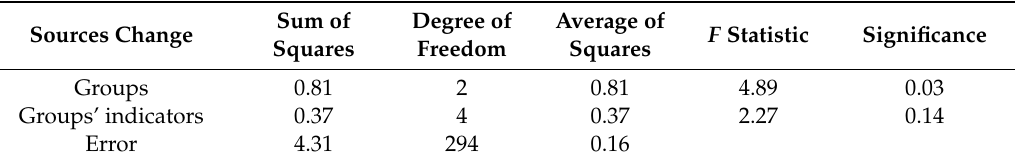
Table 5. The test results of the e ff ect between the subjects (the dependent variable in pre-construction, during construction and